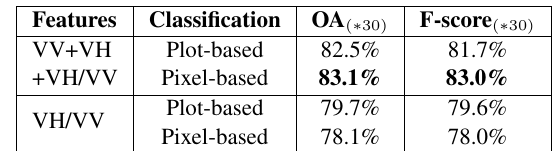
Figure 5. Plots-based correlation between field stand ages and VH/VV annual backscatter coefficient (r 2 =0.67). Classification results with the three bands VV, VH and their ra- tio VH/VV showed good performance at both plot and pixel Figure 4. Changes in the average poplar F-score on the scale with overall accuracy (OA) values of 82.5% and 83.1% south-western target tile according to the number of added respectively. When only the VH/VV ratio was considered, the samples. The initial classifier is trained on the north-eastern results were slightly lower: -2.8% and -5% of OA for respect- source tile. ively plot and pixel scales. Although the best performances were recorded with the combination of the three bands, this highlighted the interest of the VH/VV ratio to reproduce very close results.